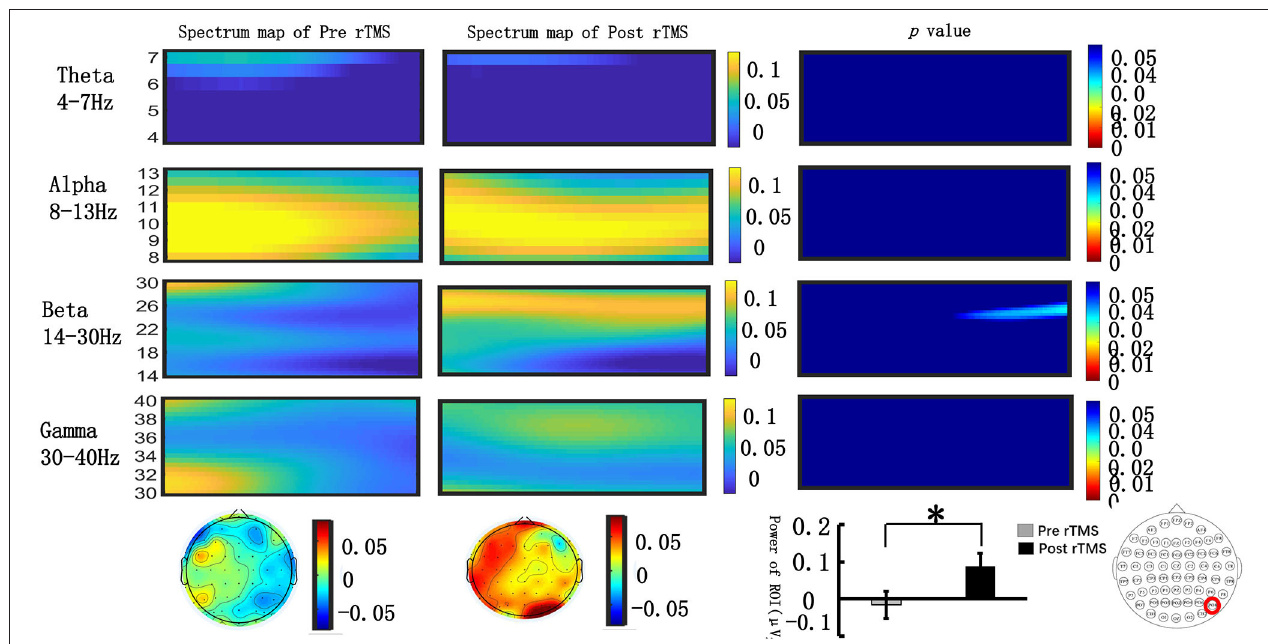
FIGURE 4 | Grand average time–frequency distribution (TFD) and β oscillation scalp topographies over the occipital lobe during the N2PC time window pre- and post-repeated transcranial magnetic stimulation (rTMS). The time–frequency distribution over the occipital lobe (PO8) in the θ (4–7Hz), α (8–13Hz), β (13–30Hz), and γ bands (30–40Hz) during the N2PC time window (170–290ms); the spectrum map of pre- and post-rTMS are listed separately in the first and second line. The third line represents the p -value of every frequency point and time point of spectrum power pre- and post-rTMS. Significant differences were found in the β (24–28Hz) oscillation scalp topographies over the occipital lobe during the N2PC time window (268–290ms); bar graph differences between pre- and post- rTMS time periods are shown at the bottom of figure. * p <